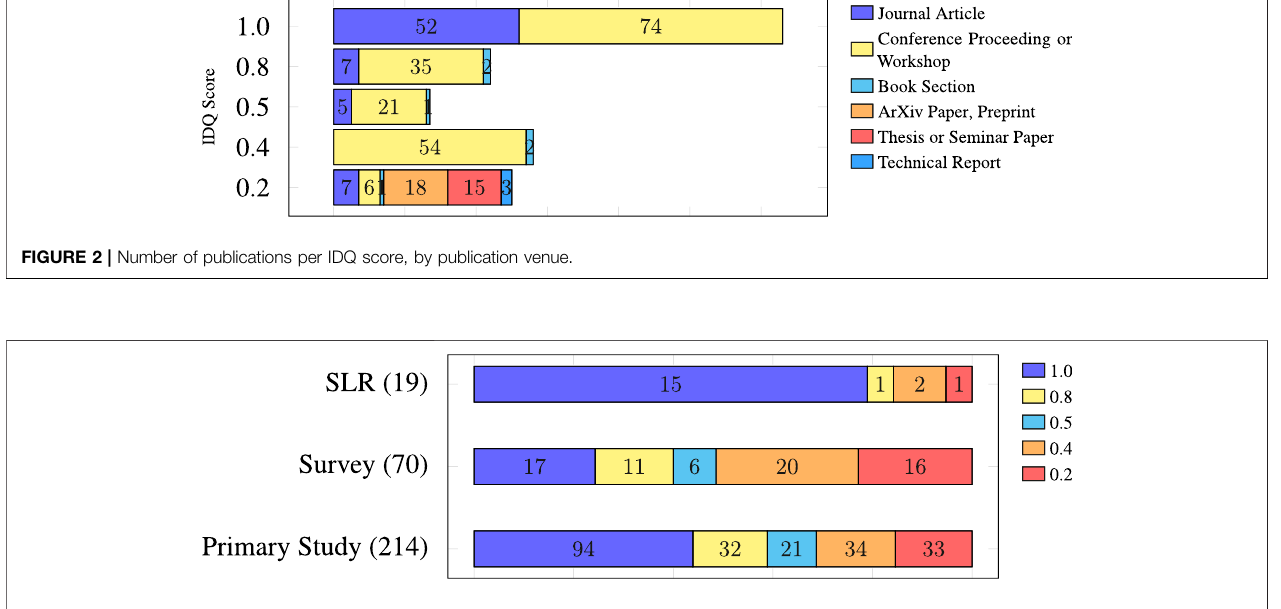
FIGURE 3 | Distribution of IDQ scores per publication